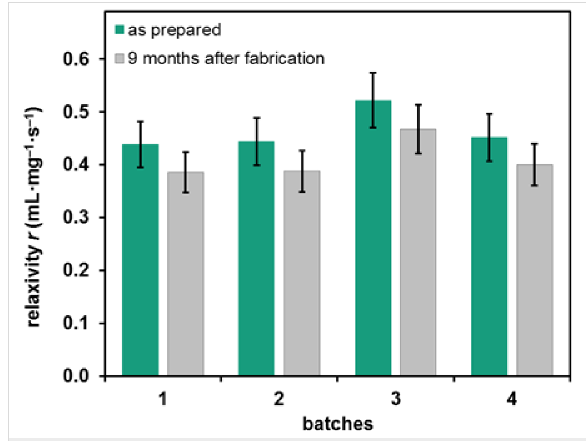
Figure 5: Relaxivity values of the four batches as prepared (green) and nine months (grey) after fabrication. Considering the error bars, the measured relaxivities directly after the preparation overlap with each other. After nine months a decrease of the relaxivity of each batch can be observed.